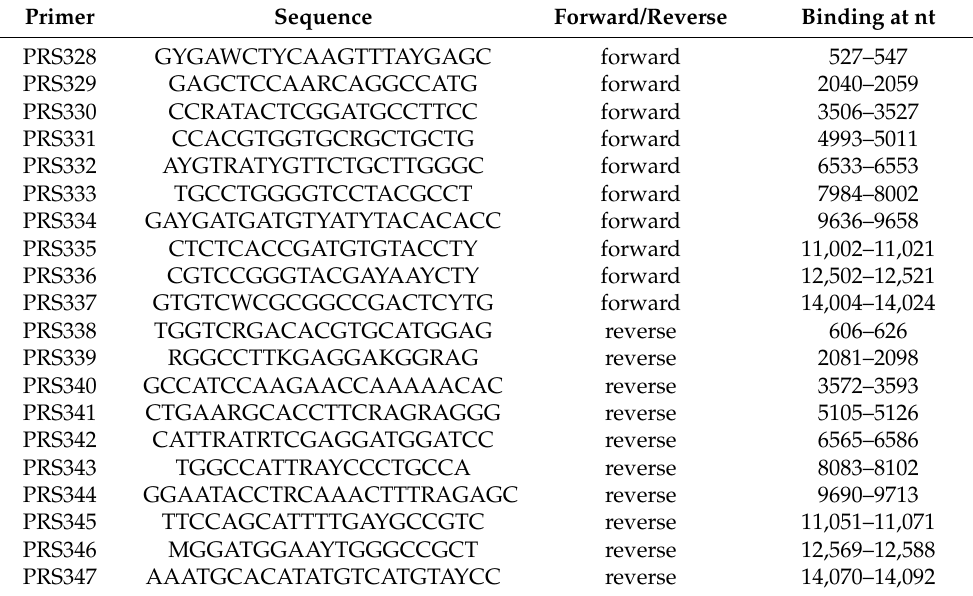
Table A1. Primers used for Sanger sequencing of PRRSV